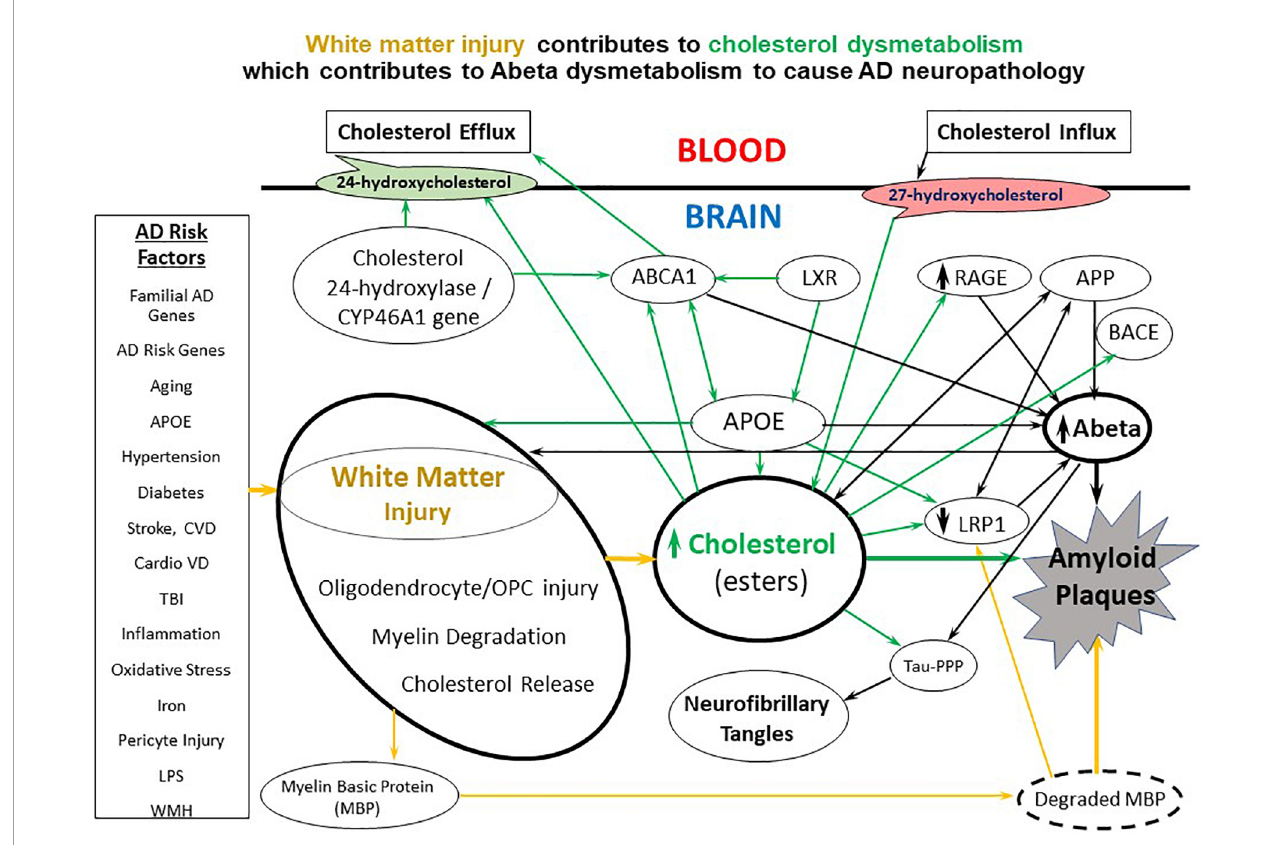
FIGURE2 A diagram of the molecular interactions between AD risk factors, white matter injury, cholesterol metabolism and transport, and Abeta metabolism and transport. A variety of environmental, systemic, and genetic factors contribute to white matter injury which causes release of cholesterol from myelin. The white matter cholesterol contributes to cholesterol dysmetabolism along with the APOE4 allele and multiple genetic risk factor genes. Cholesterol has multiple interactions with Abeta including down-regulating LRP1, upregulating RAGE and binding APP to contribute to Abeta dysmetabolism. CVD, cerebrovascular disease; CardioVD, cardiovascular disease; LPS, lipopolysaccharide; WMH, white matter hyperintensities; AD, Alzheimer’s disease; OPC, oligodendrocyte progenitor cells; BBB, blood brain barrier; dMBP, degraded myelin basic protein; APP, amyloid precursor protein; TBI, traumatic brain injury; APOE, apolipoprotein E; LRP1, low density lipoprotein receptor-related protein-1; RAGE, receptor for advanced glycation end products; ABCA1, ATP binding cassette subfamily A member 1; LXR, liver X receptor; BACE, beta secretase 1; Tau-PPP, hyperphosphorylated